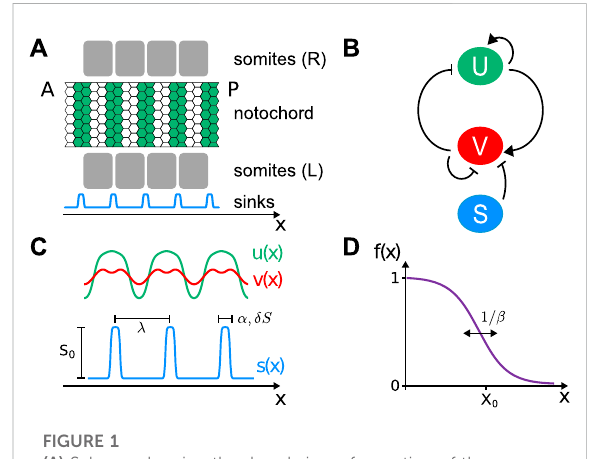
FIGURE 1 (A) Scheme showing the dorsal view of a portion of the segmented notochord (green bands) extending from anterior (A) to posterior (P). In the embryo, somites (gray squares) are located on the left and right sides relative to the notochord. The sink pro fi le(light blueline)matches somite boundaries. (B) Interactions between activator U , inhibitor V , and the inhibitor sinks S . Pointed arrows indicate activation, and blunt-ended arrows indicate inhibition. (C) Activator(greenline)andinhibitor(redline)activities. Inhibitor sinks pro fi le (light blue line) of sink strength S 0